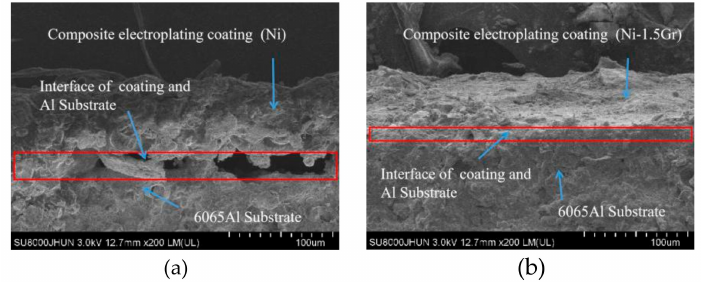
Figure 6. Sectional images of the textured electroplating coatings. ( a ) Composite electroplating coatings (Ni). ( b ) Composite electroplating coatings (Ni-1.5Gr).